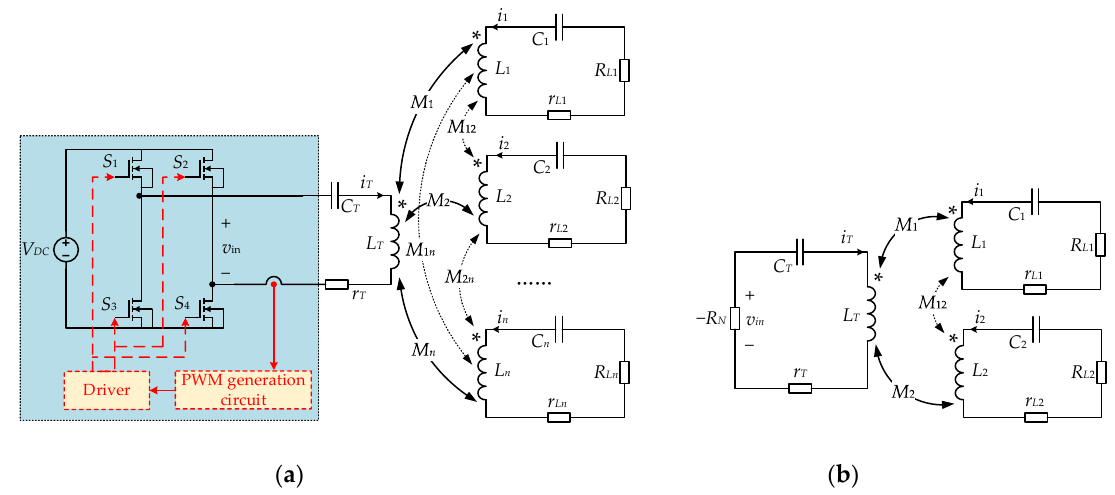
Figure 3. Schematic of multi-load PT-WPT system using series-series topology with self-oscillating full-bridge inverter: ( a ) system structure with n loads; ( b ) equivalent circuit of the dual-load PT-WPT system.